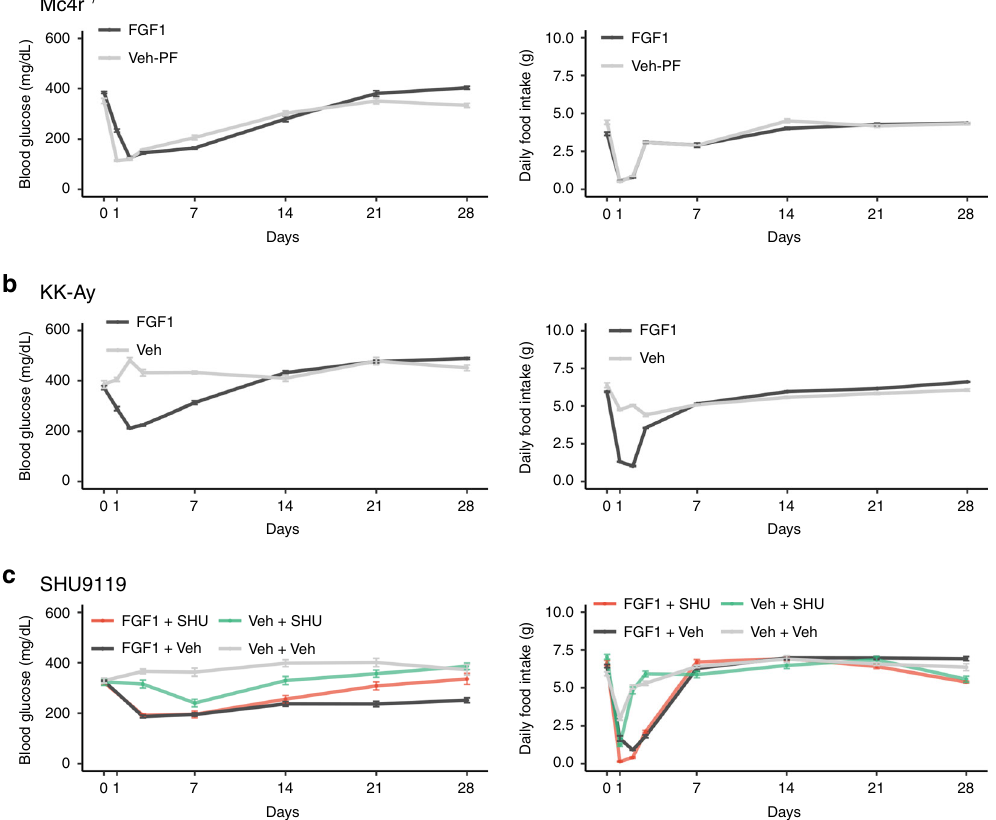
Fig. 6 FGF1-induced sustained diabetes remission is melanocortin dependent. a Blood glucose levels and food intake in diabetic Mc4r − / − (Mc4r knockout) mice injected with icv FGF1 (3 µ g) or vehicle ( n = 8/group). b Blood glucose levels and food intake in agouti (KK-A y ) mice icv injected with FGF1 (3 µ g) ( n = 12) or vehicle ( n = 9). Vehicle-injected mice were not pair-fed to the intake of mice receiving FGF1. c Blood glucose levels and food intake of diabetic Lep ob/ob mice treated with either a single icv injection of FGF1 (3 µ g) or vehicle, followed immediately by continuous icv infusion of either vehicle or the Mc4r antagonist SHU9119 (5 nmol/day) for 28 days. Veh + Veh ( n = 8), FGF1 + Veh ( n = 9), Veh + SHU ( n = 6), FGF1 + SHU ( n = 8). Data are represented as mean ± SEM, source data are provided as a Source data fi